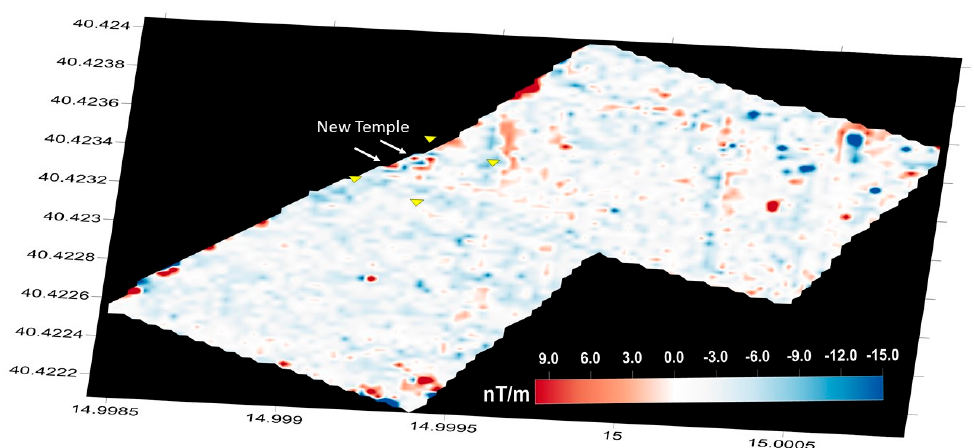
Figure 4. Geomagnetic map (Surfer software). The most significant anomalies were located in the western region of the site (white arrows), which was after investigated by GPR (yellow triangles indicate the limits of the GPR survey area). Moreover, several linear anomalies were well identified (North–South (NS) and East–West (WE) directions).